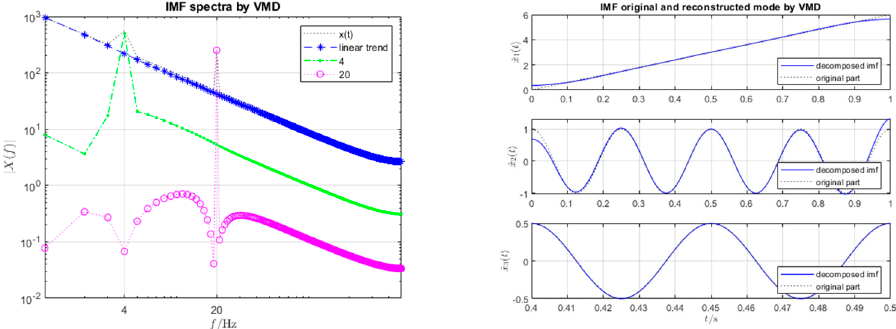
Figure 3. VMD decomposition of 𝑥 (cid:2903)(cid:2919)(cid:2917)(cid:2869) (𝑡) .